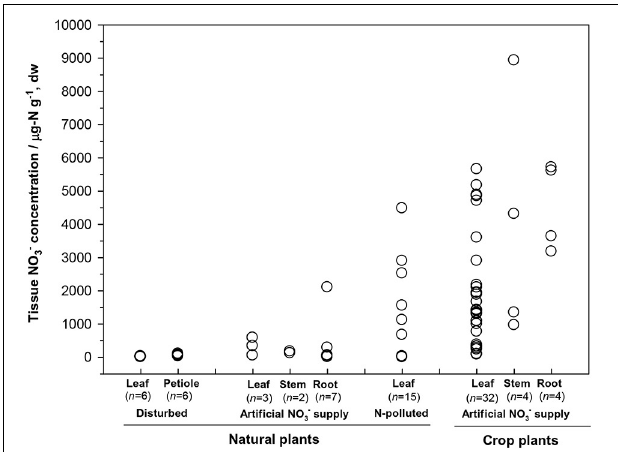
FIGURE 3 | Tissue NO − 3 concentrations in natural plants growing under disturbed conditions (acidic irrigation and liming; Gebauer et al., 1988), in N-polluted forest plants (Stams and Schipholt, 1990), in natural and crop plants with artificial NO − 3 supply (data of natural plants were cited from Gebauer et al., 1984; Stadler and Gebauer, 1992; Robe et al., 1994; Simon et al., 2014. Data of crop plants were cited from Evans et al., 1996; Yoneyama and Tanaka, 1999; Prasad and Chetty, 2008 and references cited